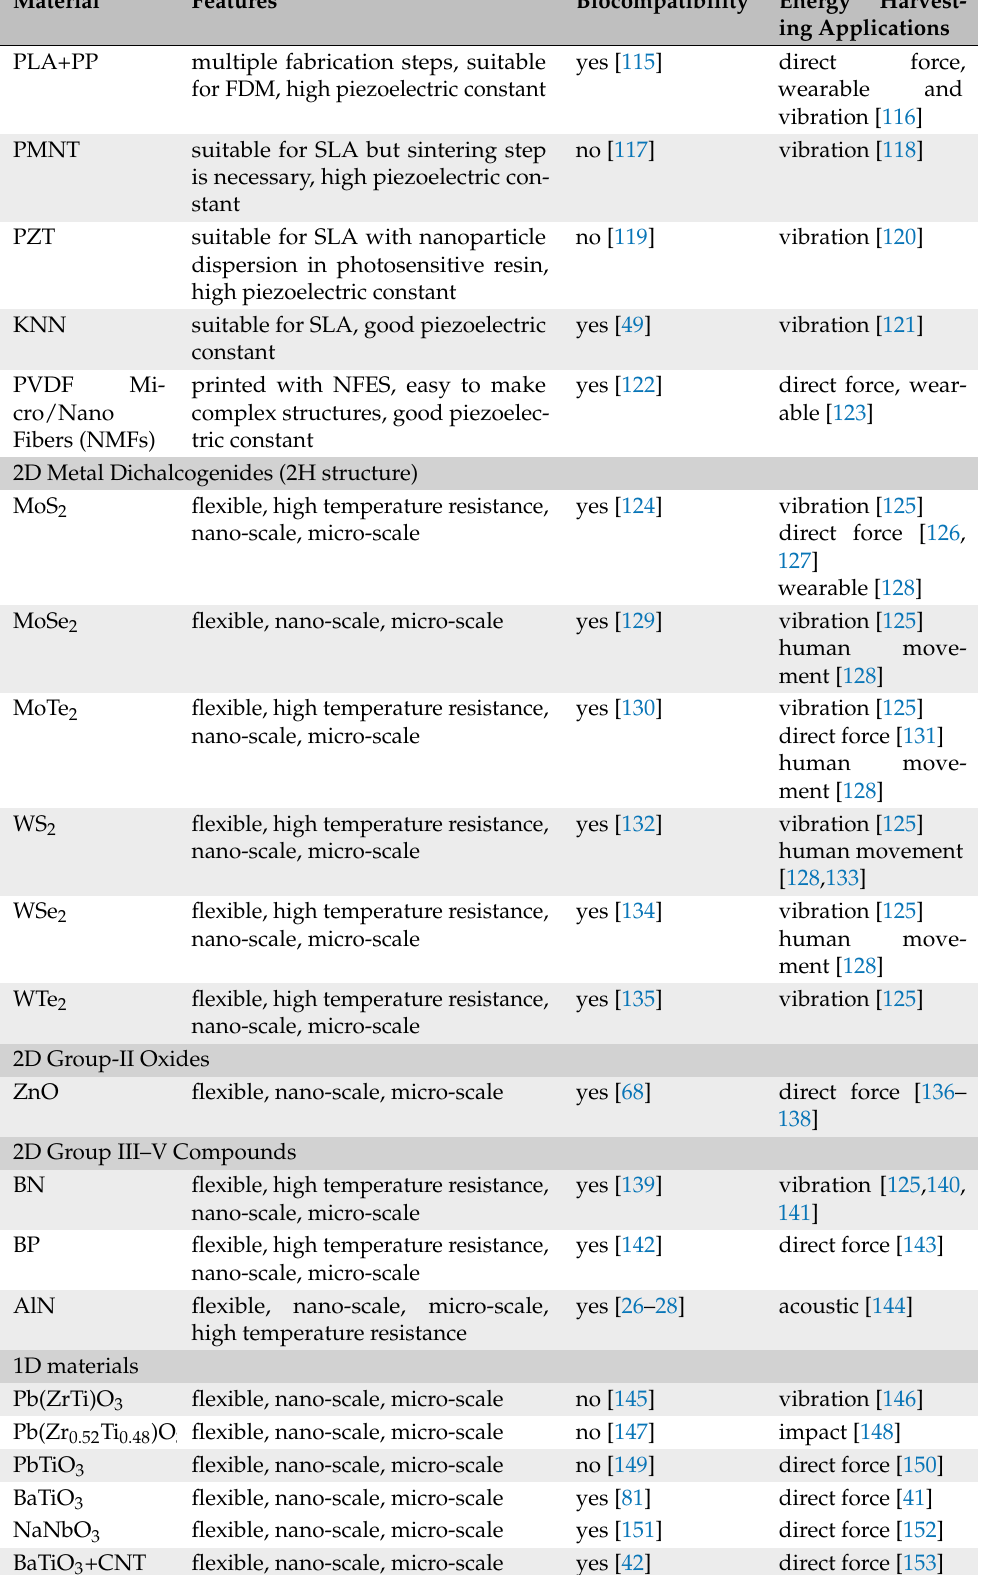
Table 1. Cont. Material